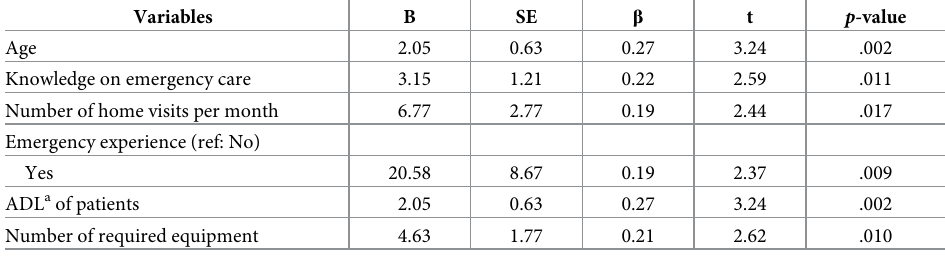
Table 5. Factors associated with caring behaviors of family